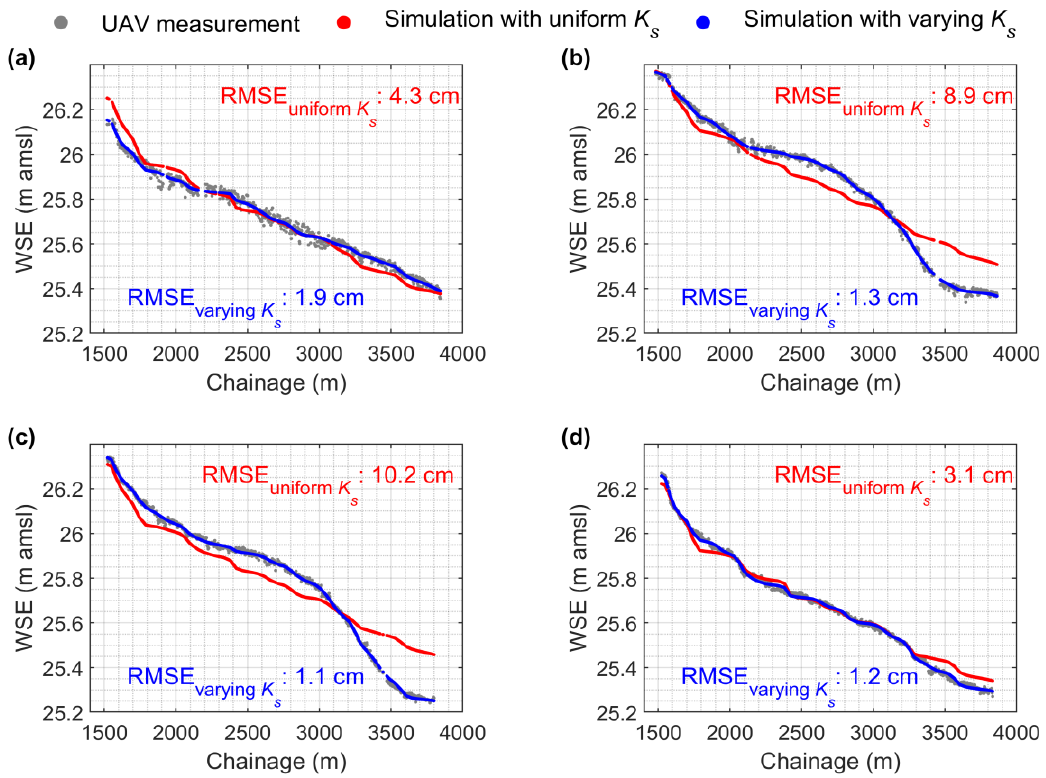
Figure 8. Simulated WSE against UAV-borne measurements using spatially uniform and distributed Gauckler-Strickler K s ( a ) August, ( b ) September, ( c ) October, and ( d ) November.